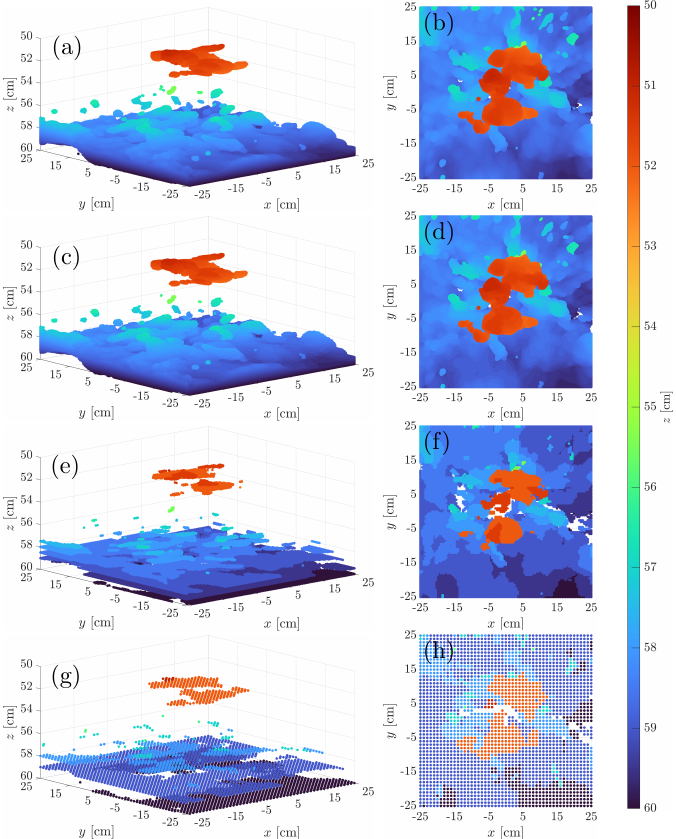
Figure 10. A comparison of the results of 0.05 cm ( a , b ), 0.1 cm ( c , d ), 0.5 cm ( e , f ), and 1 cm ( g , h ) resolution imaging. The images lose details at resolutions larger than 0.1 cm, but the finer 0.05 cm resolution image provides no further benefit.